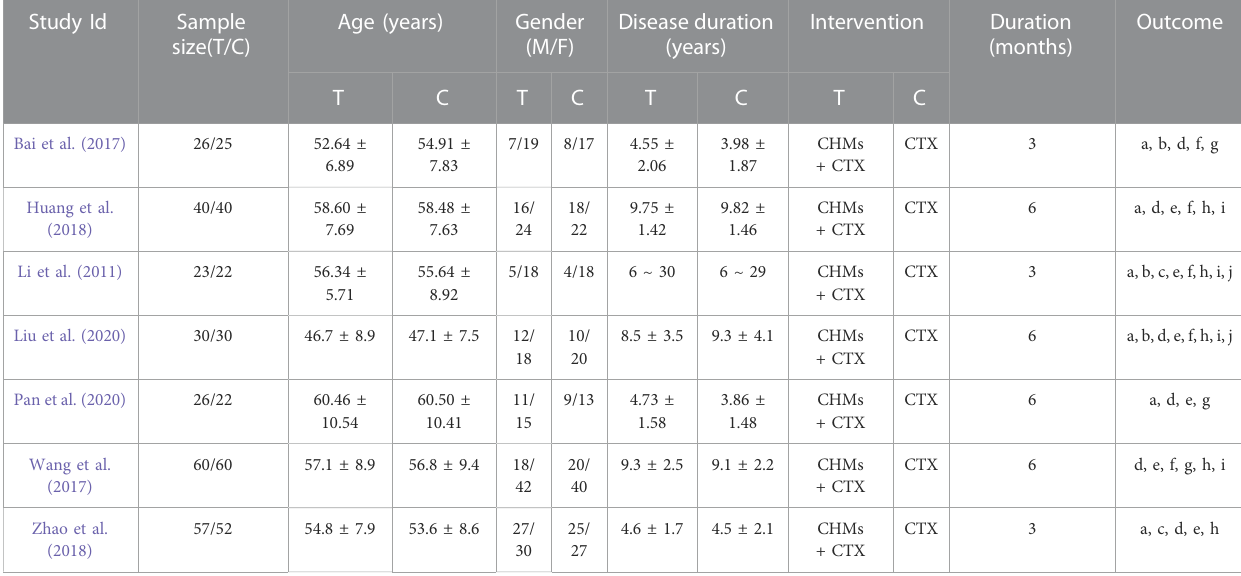
TABLE 1 The characteristics of the included studies.